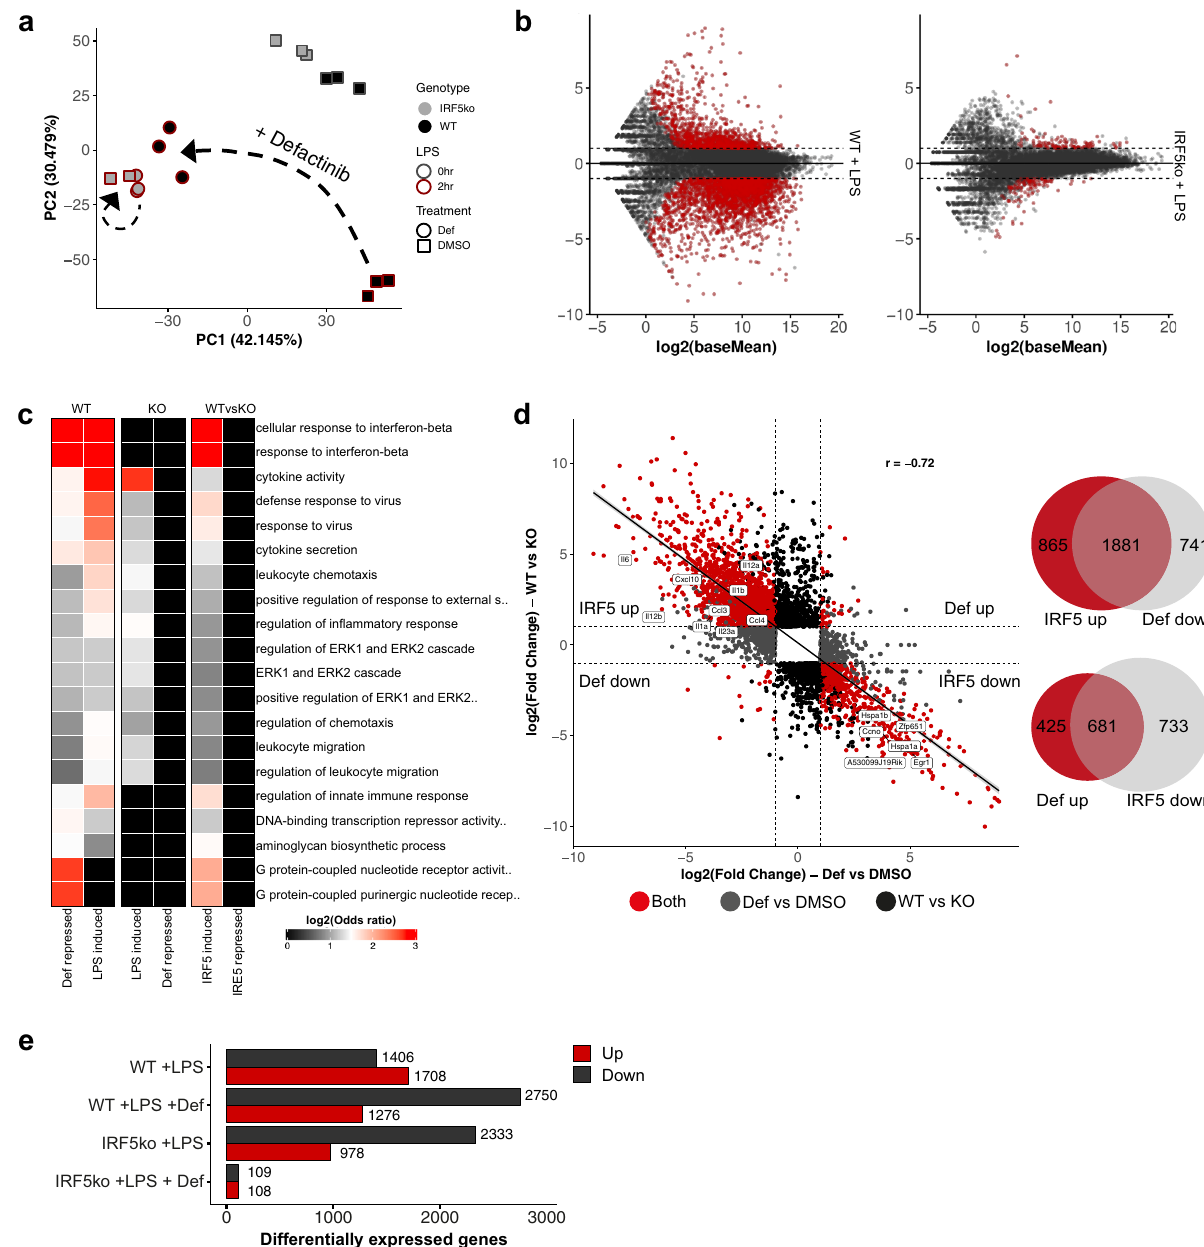
Fig. 5 Defactinib inhibits IRF5-dependent gene expression. a PCA analysis of RNA-seq data from WT and Irf5 − / − pretreated with 3.5 μ M defactinib (def) or DMSO control for 1 h and further stimulated with LPS for 0 or 2 h. b MA plots depicting the effect of defactinib on LPS-stimulated BMDMs from WT or IRF5 − / − mice. Differentially expressed genes (fold change > 1 and padj < 0.05) are highlighted in red. c GO enrichment analysis for differentially expressed genes (as in b ). d Correlation analysis of IRF5 and defactinib regulated genes after 2 h LPS stimulation. Red indicates genes are differentially expressed (signi fi cance as in b ) in both comparisons, genes regulated by IRF5 only (black), genes regulated by defactinib only (grey). Venn diagrams demonstrate the overlap between IRF5 and defactinib regulated genes. e Number of DE genes from